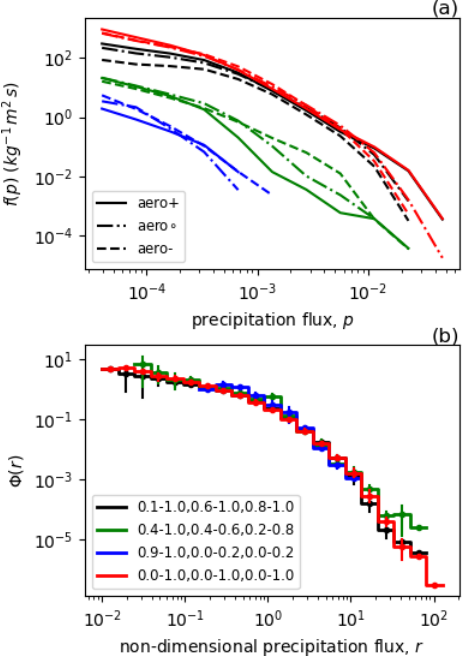
Figure 8. The regime dependence of the rainfall rate distributions for the deep convective (black lines), low-cloud-dominated (blue lines) and intermediate (green lines) cloud regimes. The red lines show the distributions for the whole domain (all cloud-fraction combinations). (a) The simulated rainfall rate frequency distribu- tions for the three regimes of fractional cloudiness and the total (whole domain) distributions. (b) The histograms of the universal distributions for each regime, with the inter-model ranges indicated by the vertical bars in each non-dimensional rainfall rate interval.